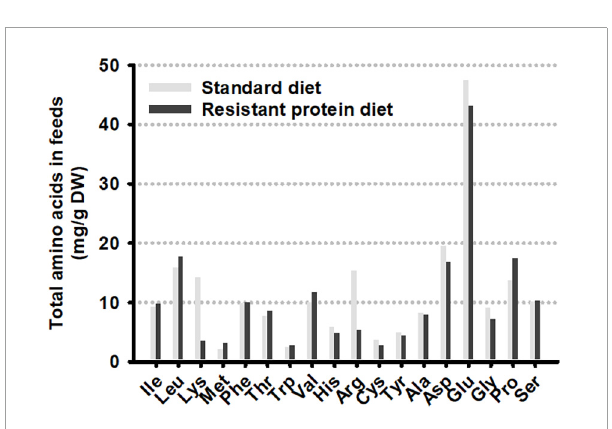
FIGURE5 Total amino acid composition of the two formulated